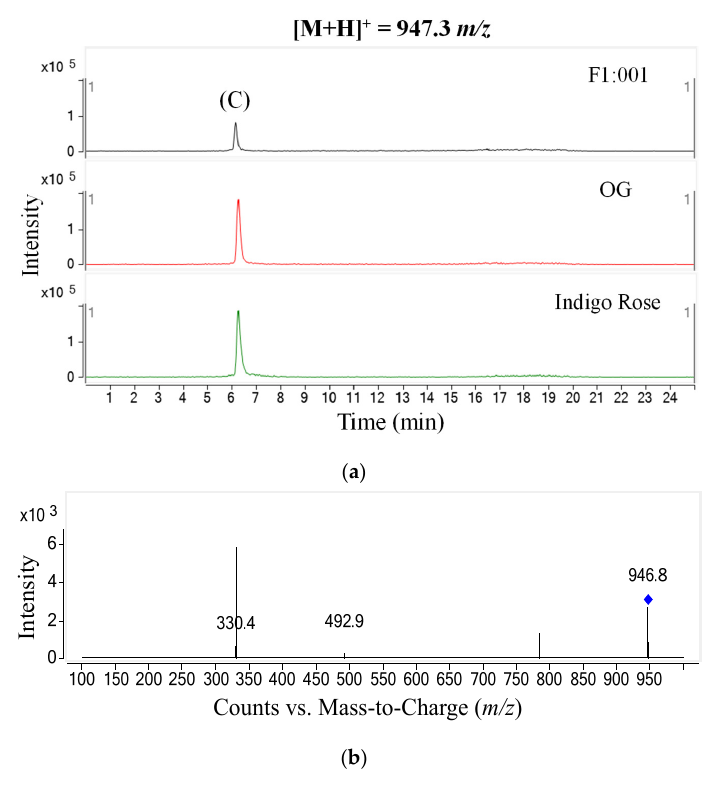
Figure 5. Chromatogram ( a ) and MS–MS fragments ( b ) of [M+H]+ ion with 743.2 m / z in three tomato varieties.